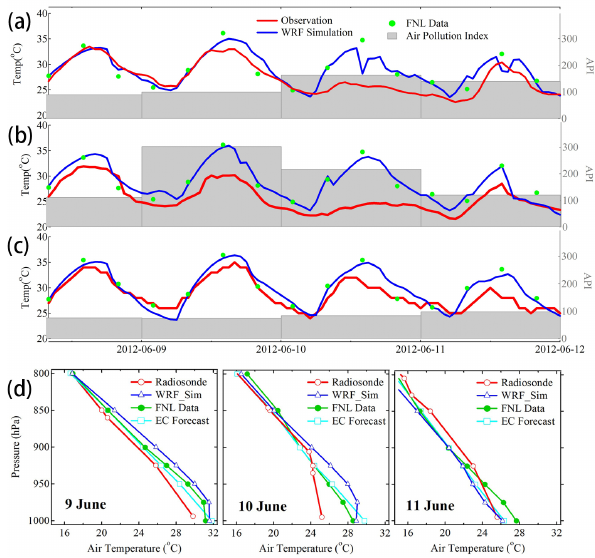
Fig. 6. A comparison of (a) 2m air temperature from the WRF sim- ulation, FNL and from the observations, and a daily mean air pol- lution index in Nanjing, (b) and (c) same as (a) but for Yangzhou and Hefei City, respectively, and (d) comparisons of air temperature vertical profiles from the WRF simulations, FNL data, ECMWF forecast products and radiosonde measurement over Nanjing at 20:00LT for 9–11 June